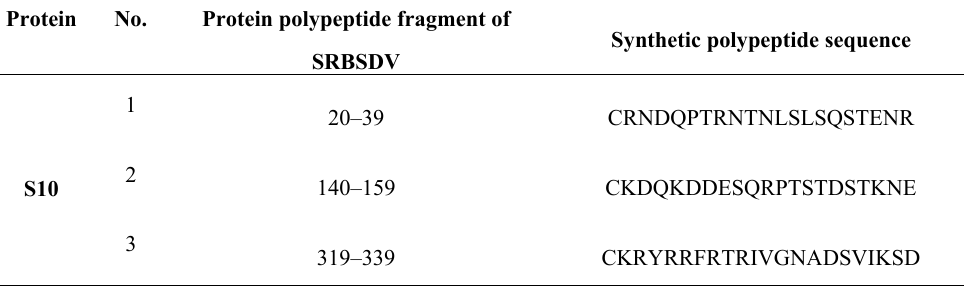
Table 2. Information on the polypeptide sequences of the SRBSDV antigens Protein No. Protein polypeptide fragment of Synthetic polypeptide sequence SRBSDV 20–39 S10